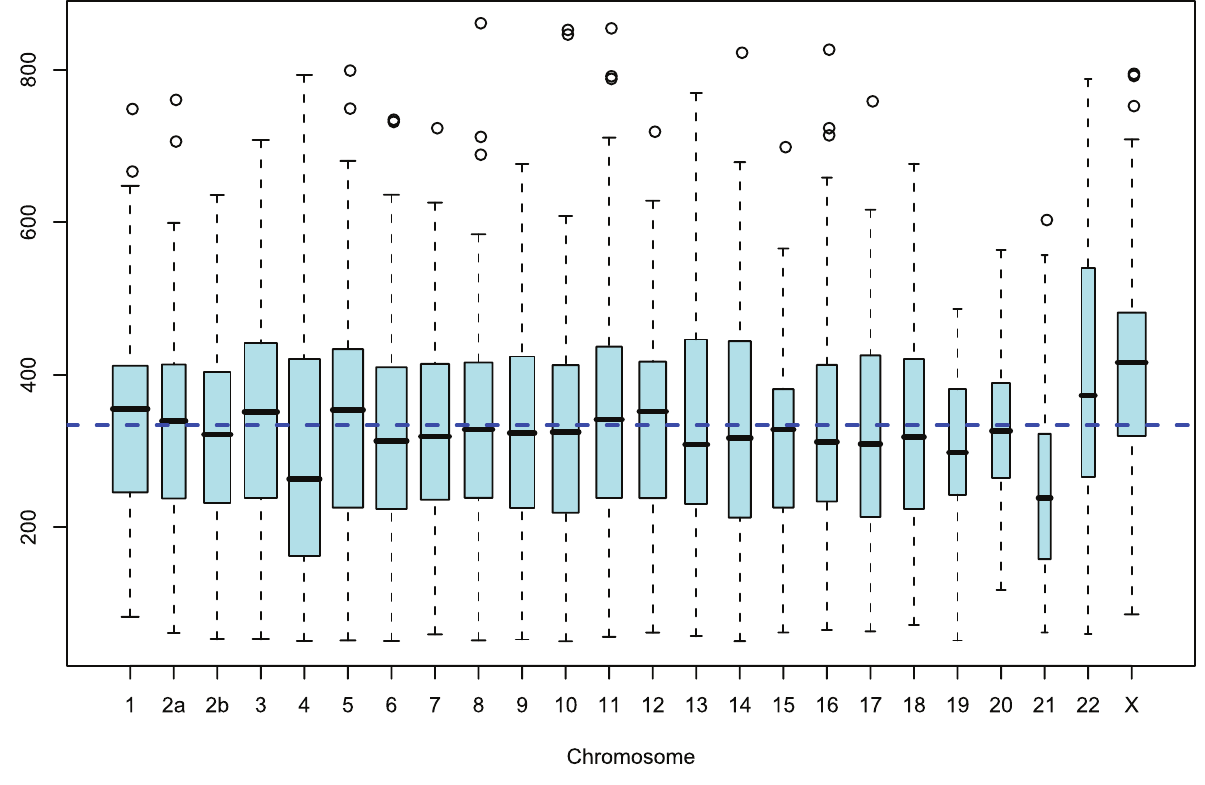
Figure 9. Distribution of sub-speciation time estimates for each chromosome. The box plot shows the distribution of the estimated sub- speciation time on each chromosome. The dashed line shows the genome-wide average. In general, the estimates are reasonably consistent between the chromosomes, although chromosome 21 has a slightly smaller value. doi:10.1371/journal.pgen.1001319.g009 PLoS Genetics |